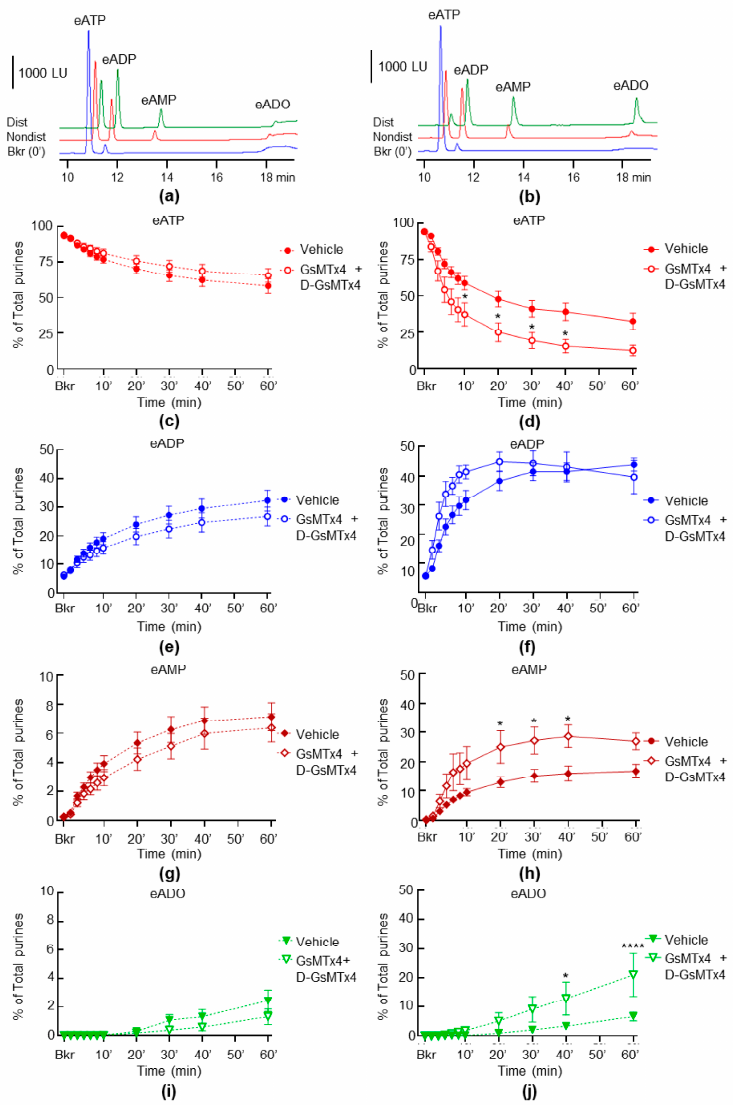
Figure 4. Effects of GsMTx4 plus D-GsMTx4 on the hydrolysis of eATP by s-ENTDs released in cELS of nondistended and distended detrusor-free bladder preparations. Original chromatograms of eATP in beaker (Bkr, blue, 0 ′ , no enzyme present) and at 60 min of enzymatic reaction in cELS of nondistended (Nondist, red) and distended (Dist, green) bladder preparations treated with vehicle ( a ) or GsMTx4 plus D-GsMTx4 ( b ). LU, luminescence units. Summarized data showing changes in eATP, eATP, eADP, eAMP and eADO in the presence of vehicle (KBS, n = 8) and GsMTx4+D-GsMTx4, 1 µM each ( n = 6) in nondistended ( c , e , g , i ) and distended ( d , f , h , j ) bladder preparations; n , number of bladder preparations. eATP, eADP, eAMP and eADO are presented as percentages of total purines (eATP + eADP + eAMP + eADO) present in reaction solutions. Asterisks denote significant difference from vehicle controls. * p < 0.05, **** p < 0.0001. Two-way ANOVA with Sidak’s multiple comparisons